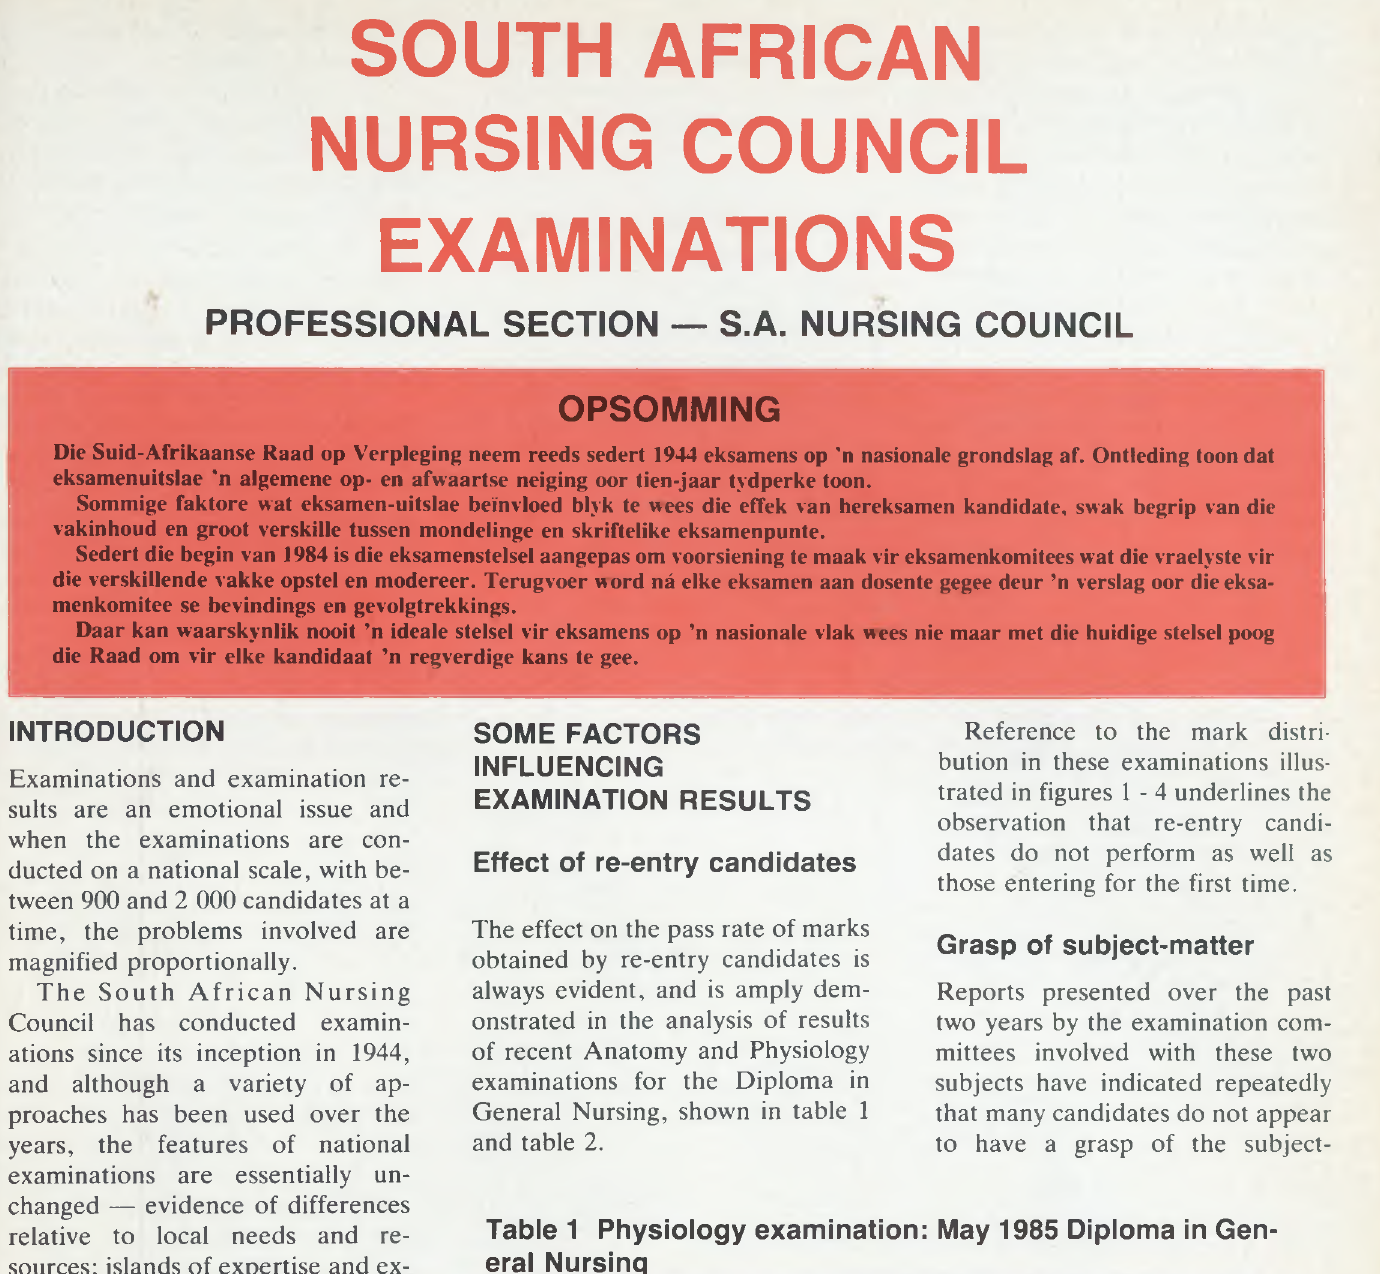
Table 1 Physiology examination: May 1985 Diploma in Gen­